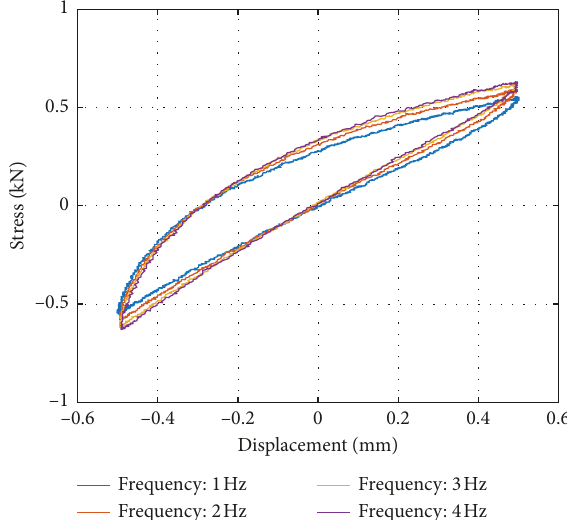
Figure 8: Dynamic hysteresis loop of MR with the density of 3 under different loading frequencies. 2.5g cm · −